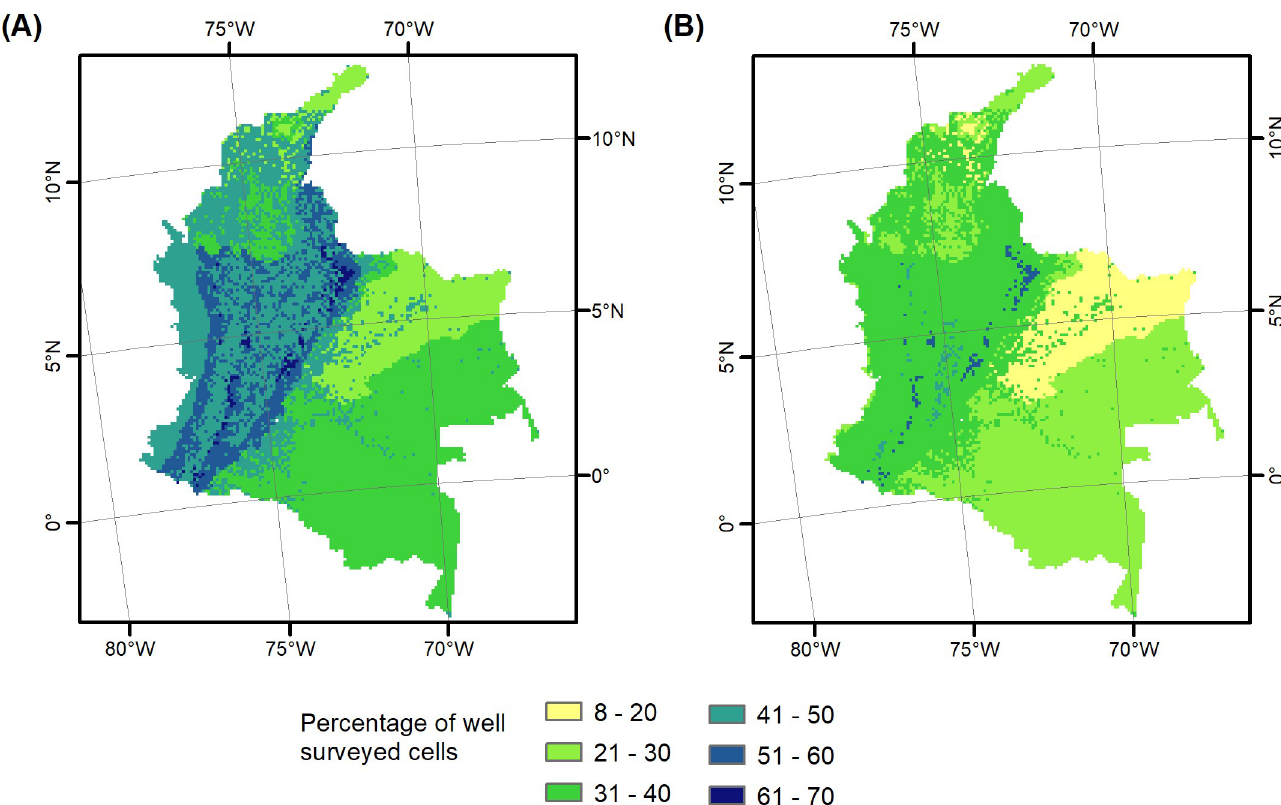
Fig 4. Survey completeness for all vascular (A) and useful (B) plants by bioregion. Percentage of 10 × 10 km well surveyed grid cells, defined as those with � 25 observations, is calculated by bioregion.